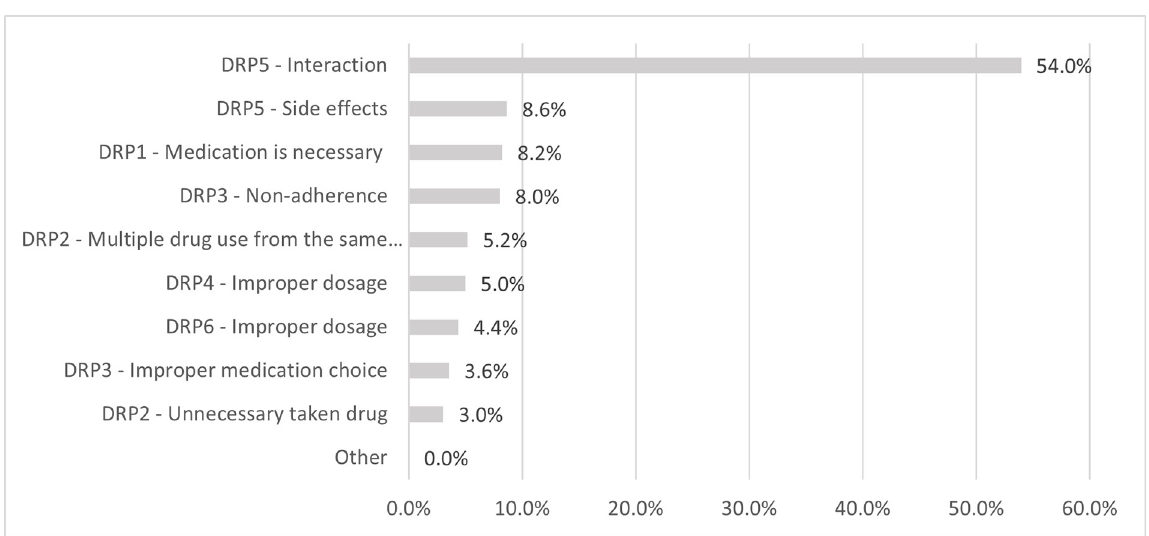
Fig 2. The distribution and order of occurrence of the underlying causes of drug-related problems. DRP: Drug-Related Problem; n(DRP) = 984.